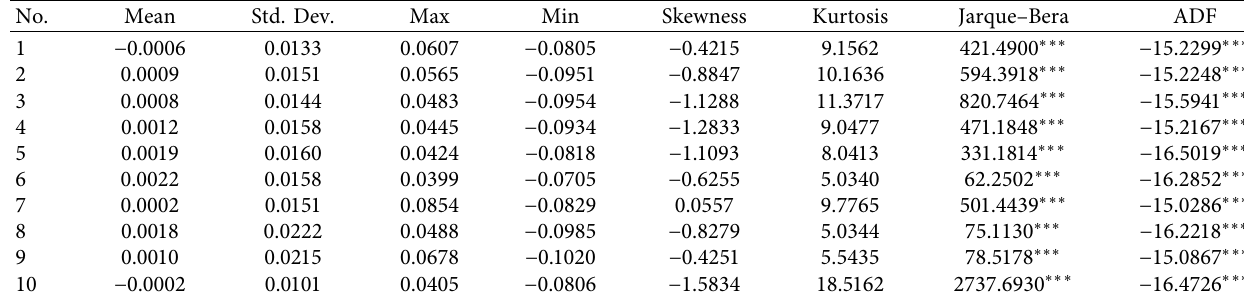
Table 2: The statistics of 10 industry sector